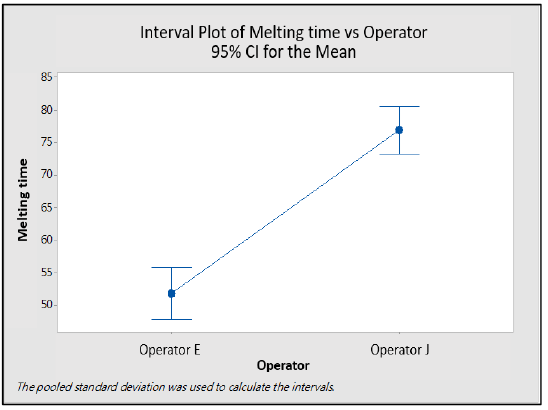
Figure 8. Comparison of the differences between the two operators.